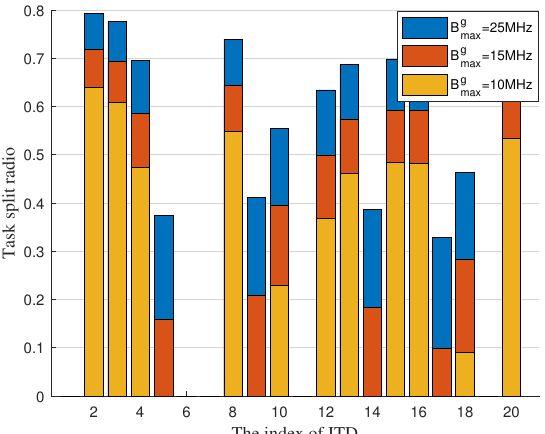
Figure 5. Task split radio of each ITD with maximum bandwidth of air channel.